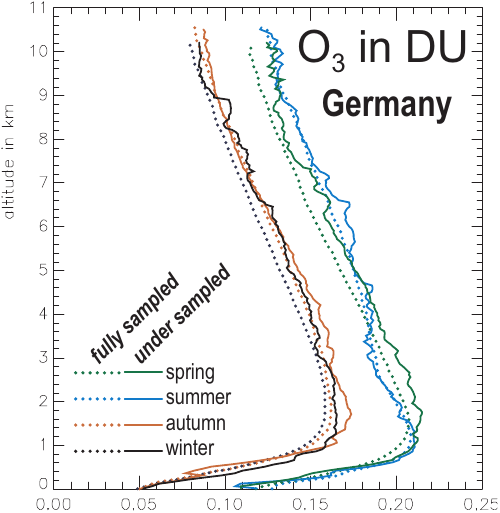
Fig. 9. Seasonal tropospheric O 3 profiles for Germany as sampled by MOZAIC (16041 profiles, plain lines) and under sampled con- sistently with the Los Angeles (300 profiles, dotted lines) in 24h